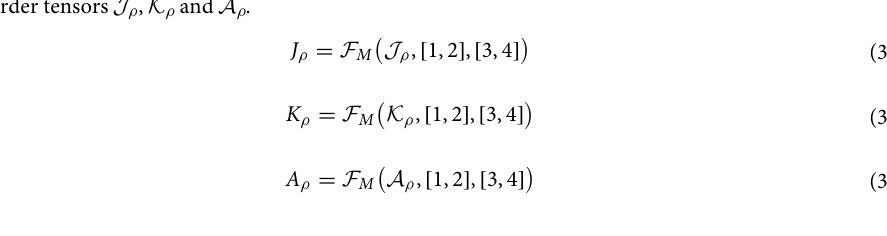
The system sequence knowledge base J ρ and its